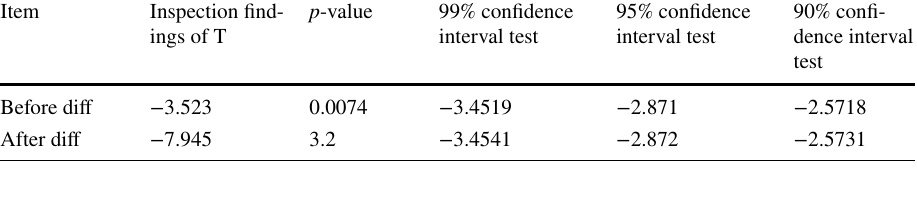
Table 2 Test result for the stability of the load data